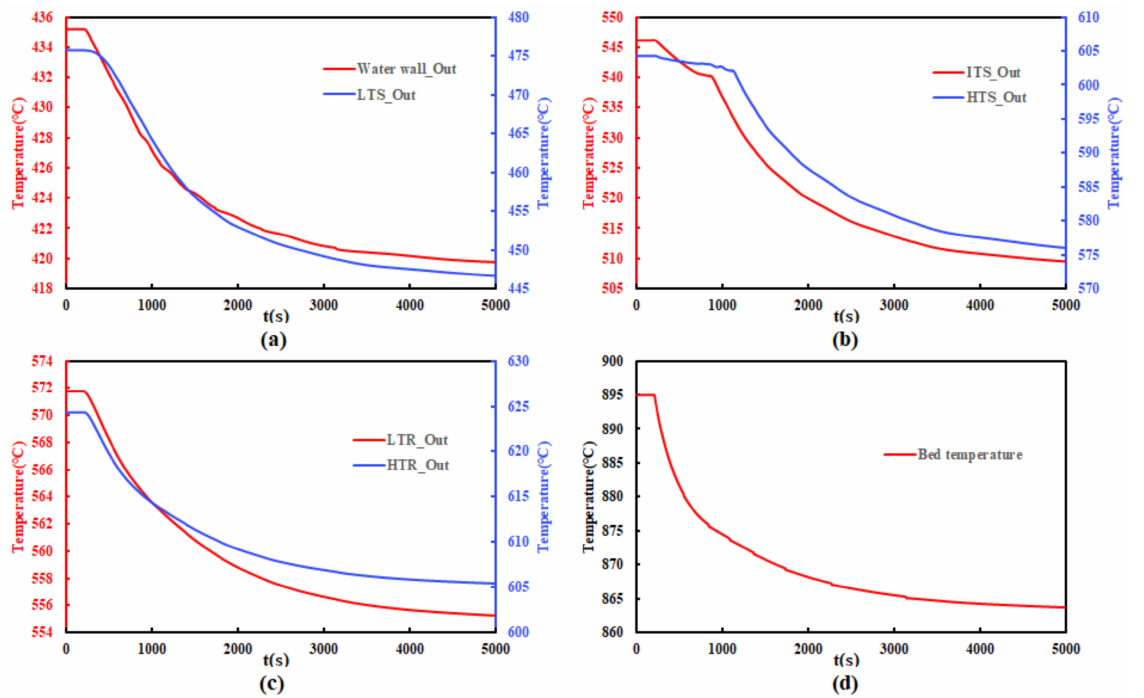
Figure 15. Temperature response when coal mass flow decreased by 5%: ( a ) the steam temperature of the water wall outlet and LTS outlet; ( b ) steam temperature of ITS and HTS outlet; ( c ) steam temperature of LTR outlet and HTR outlet; ( d ) bed temperature.